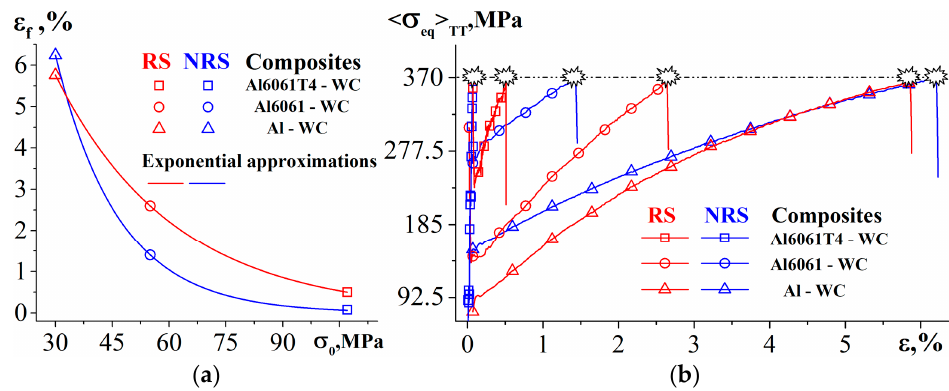
Figure 12. Composite elongation at the fracture onset vs. matrix yield stress ( a ) and equivalent stress evolution in the TT-type region shown in Figures 1 and 11 ( b ).